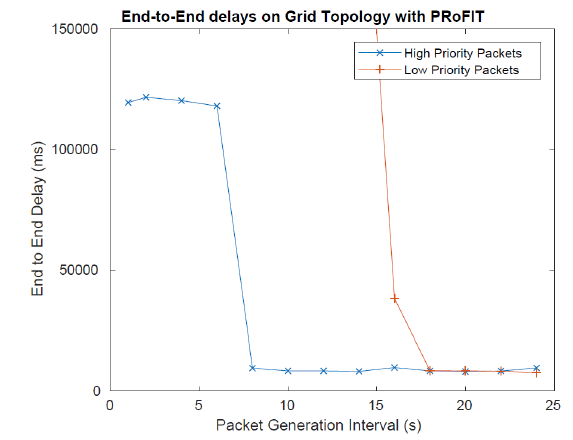
Figure 8 . End-to-End Delays on Grid Topology with PRoFIT